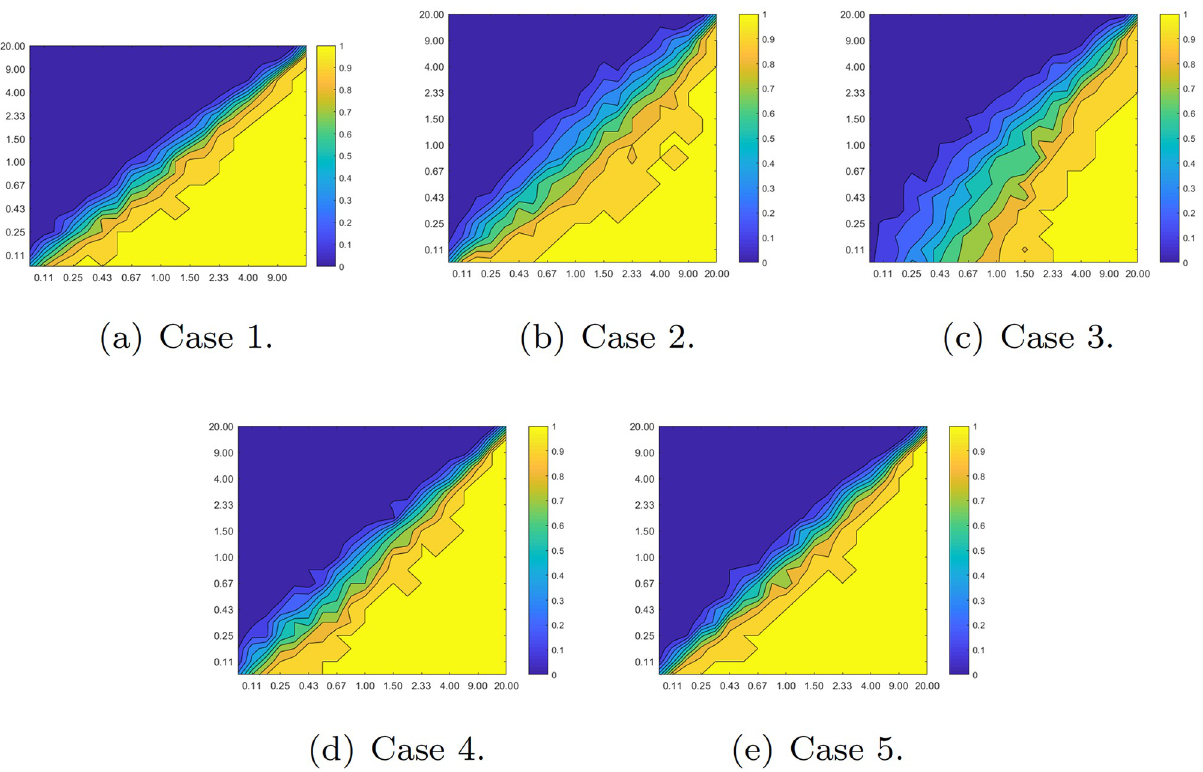
Fig 5. Convergence of the quantised consensus algorithm to the coordinators class with respect to the ratios a 12 ratio a 12 and the y-axis the ratio a 21 a 11